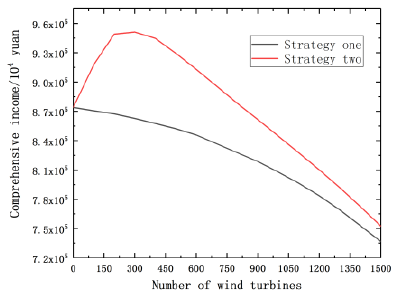
Figure 9. Strategy 1 and 2: comprehensive income comparison. Table 2. Wind farm, PV, pumped storage capacity allocation and comprehensive benefit statement.